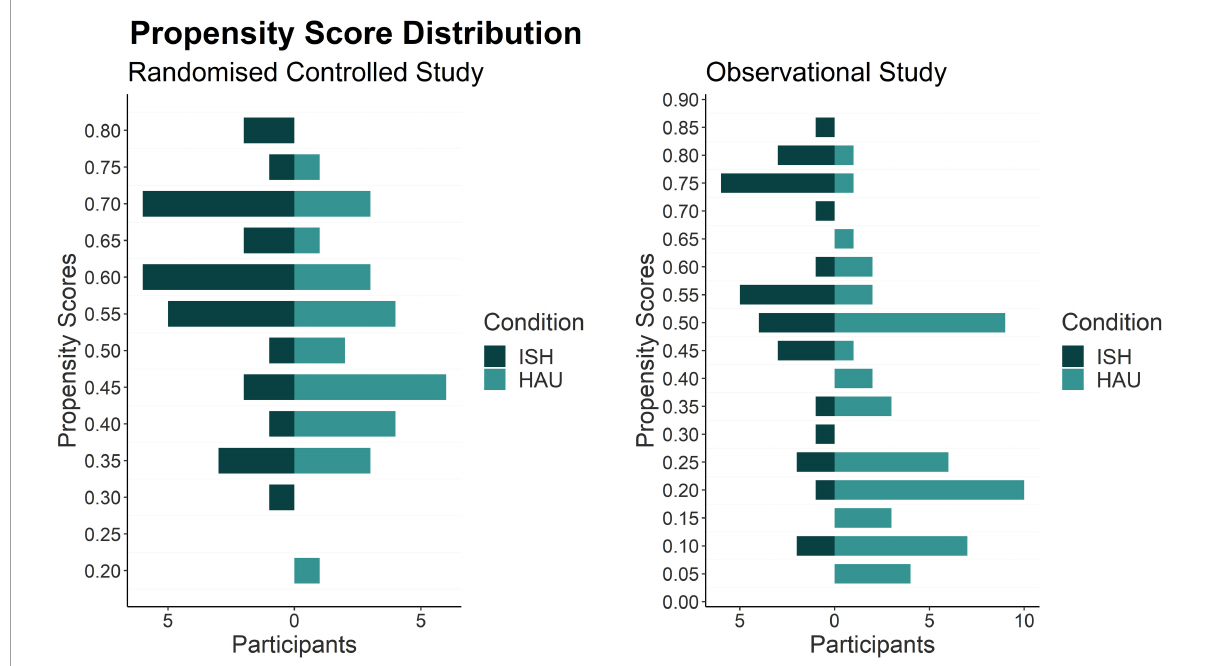
FIGURE2 Histogram of PS-distribution between study conditions in the RCT and the OS. ISH, Independent Supported Housing; HAU, housing as usual.